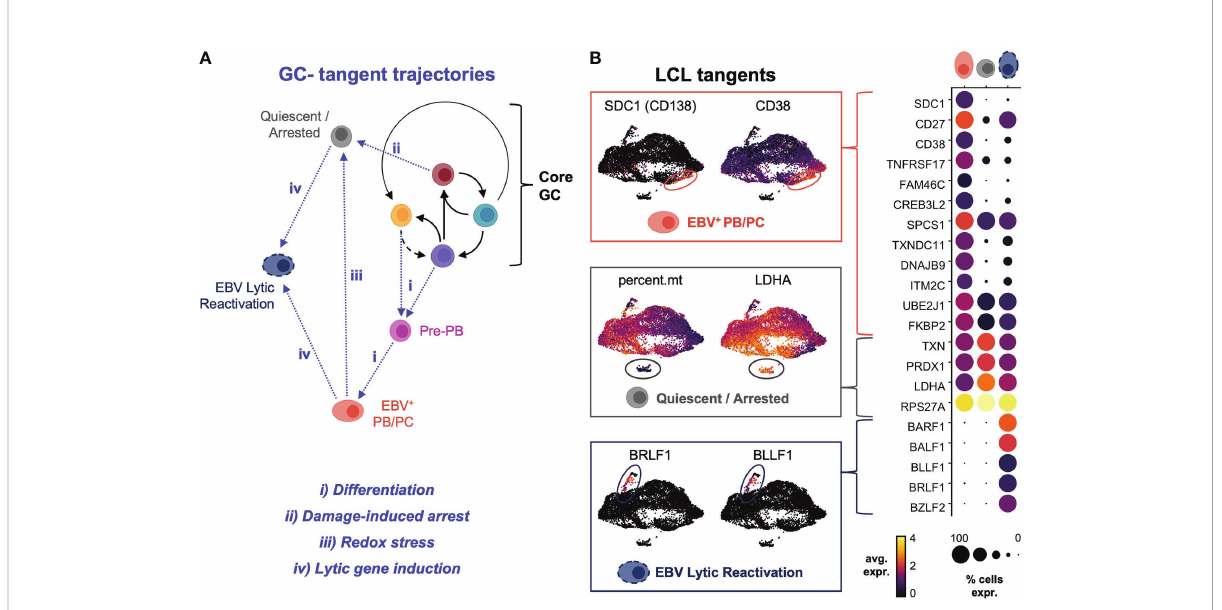
FIGURE 5 Plasma cell differentiation, growth arrest and quiescence, and viral reactivation de fi ne tangent fate trajectories arising from core GC dynamics. (A) Model of extra-GC tangent fate trajectories leading to additional phenotypes observed from LCL scRNA-seq data. Proposed triggers associated with each trajectory are annotated in blue. (B) Differentially expressed markers de fi ning tangent phenotypes in LCLs (PB/PC = plasmablasts/plasma cells, quiescent/arrested cells, and lytic